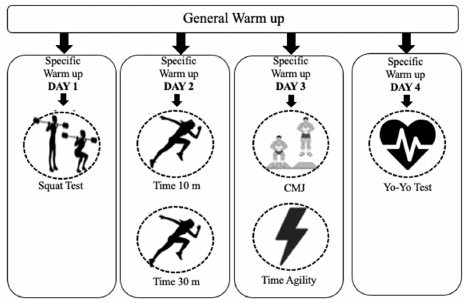
Figure 1. Physical fitness test timeline.